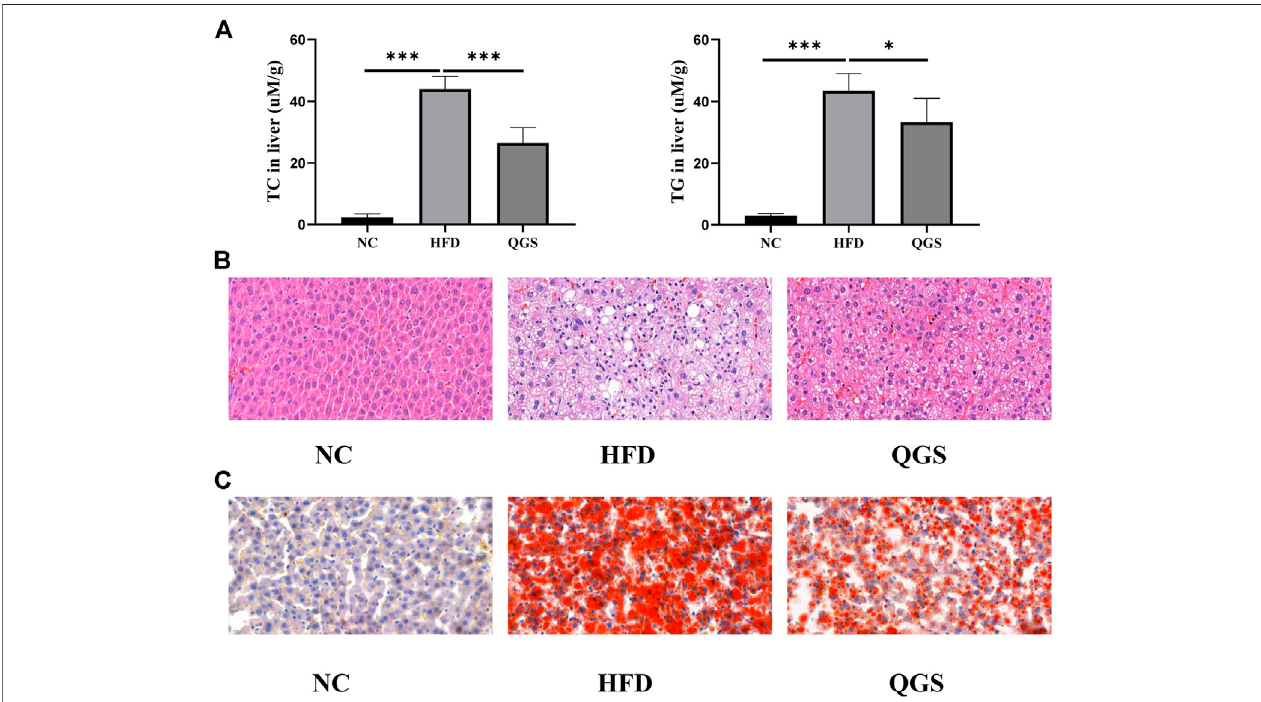
FIGURE3| Levels oflipid accumulation inthe liver. (A) Levels ofTCand TGintheliver. (B) Hematoxylinand eosinstainingoflivertissue at × 40.0magni fi cation. (C) Oilred O staining of liver tissue at × 40.0 magni fi cation. The data are presented as means ± SEM. ns, no signi fi cant difference. * p < 0.05, ** p < 0.01, *** p < 0.001, vs. the HFD group.